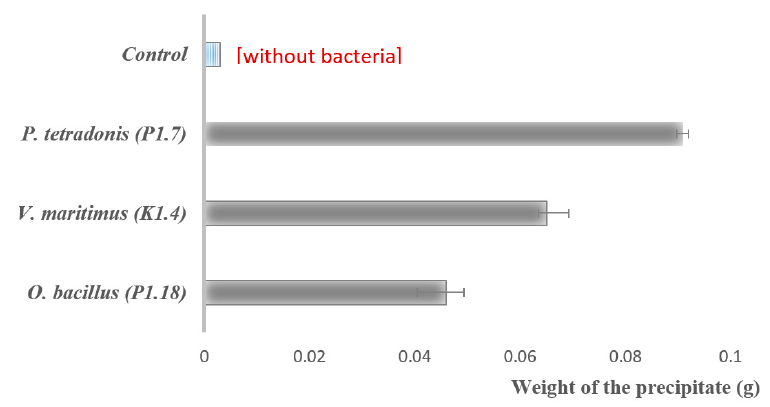
Figure 5. Microbial induced carbonate precipitation capacity of isolated strains.